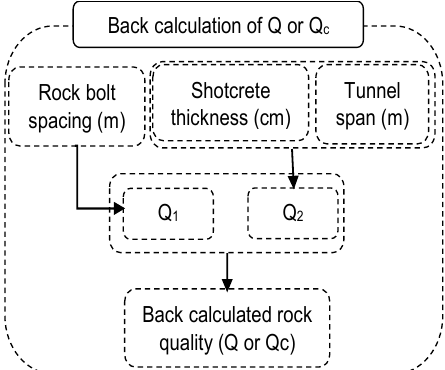
Figure 3. Procedure for the back-calculation of the tunnel quality index ( Q or Qc ) from actual tunnel spans and installed supports [46].